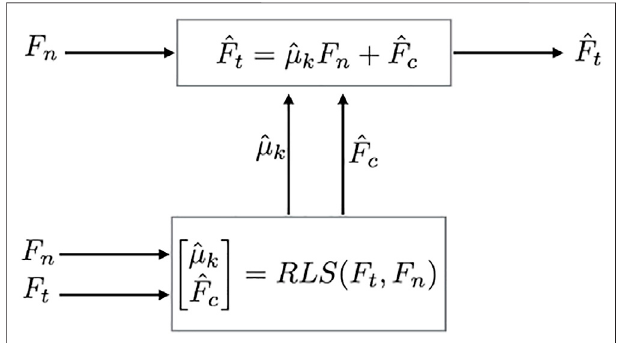
^ F t is predicted by